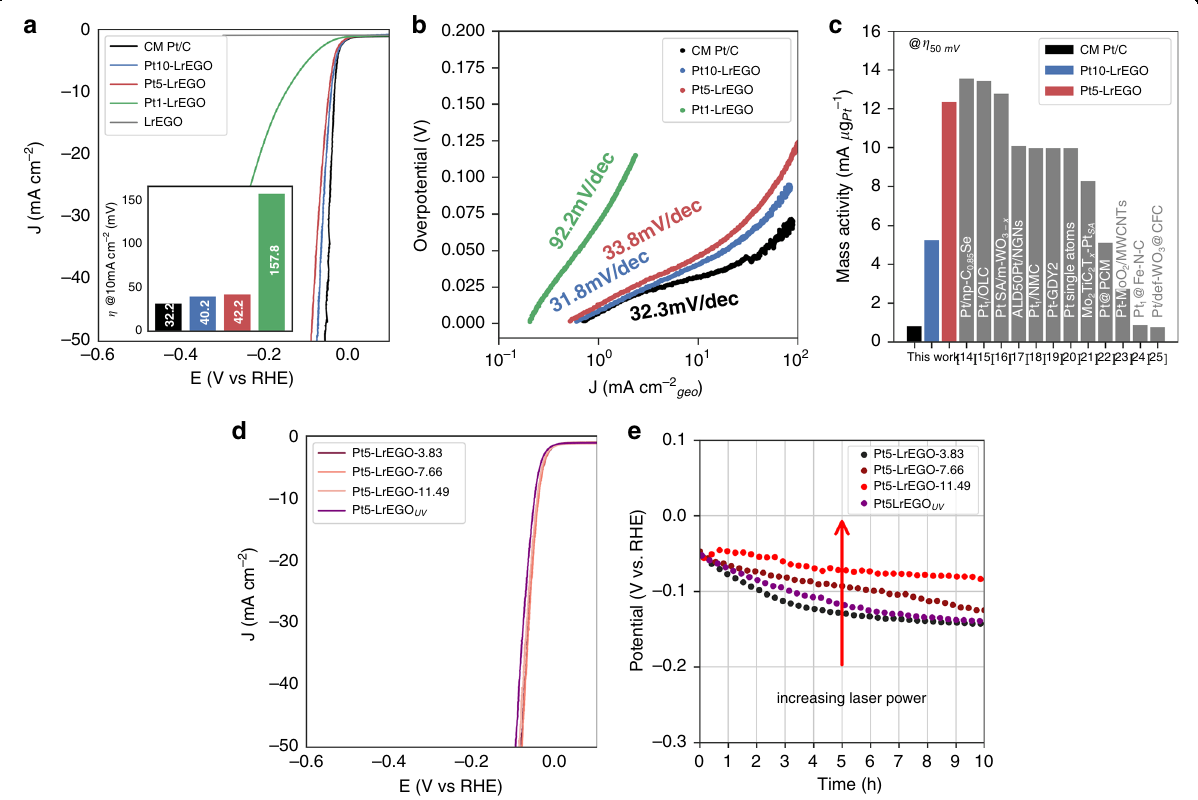
Fig. 6 Hydrogen evolution performance of the Pt-LrEGO samples. a LSVs (10 mV s − 1 ; after ohmic-drop correction) of the commercial Pt/C (20 wt Pt %) and the Pt-LrEGO catalysts prepared by laser irradiation (1064 nm; 7.66 mJ cm − 2 ) of the EGO fi lms infused with Pt precursor solutions at different concentrations; the LSVs were recorded in N 2 -saturated 0.5 M H 2 SO 4 at a rotation speed of 1600 rpm; the inset shows the overpotential of samples at a current density of 10 mA cm − 2 . b Tafel slopes of the commercial Pt/C and Pt10-LrEGO, Pt5-LrEGO, and Pt1-LrEGO. c Mass activities of the commercial Pt/C, Pt-LrEGO, and the literature reported Pt-based SACs at an overpotential 50 mV. The bibliographic information of the reference numbers can be found in Supplementary Table S6 in Supporting information. d LSV of Pt5-LrEGO samples obtained by 1064 nm laser irradiation